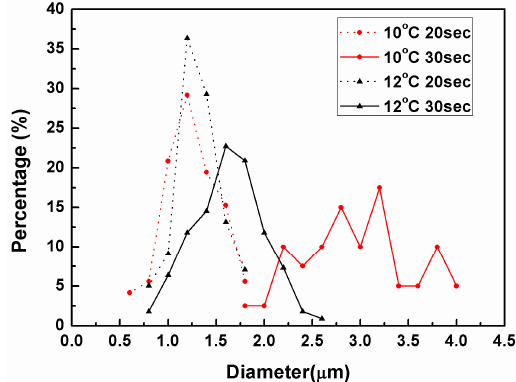
Figure 13. Diameter distribution of machined holes at 10 ∘ C and 12 ∘ C with a power density of 1.2 × 10 8 W/cm 2 .